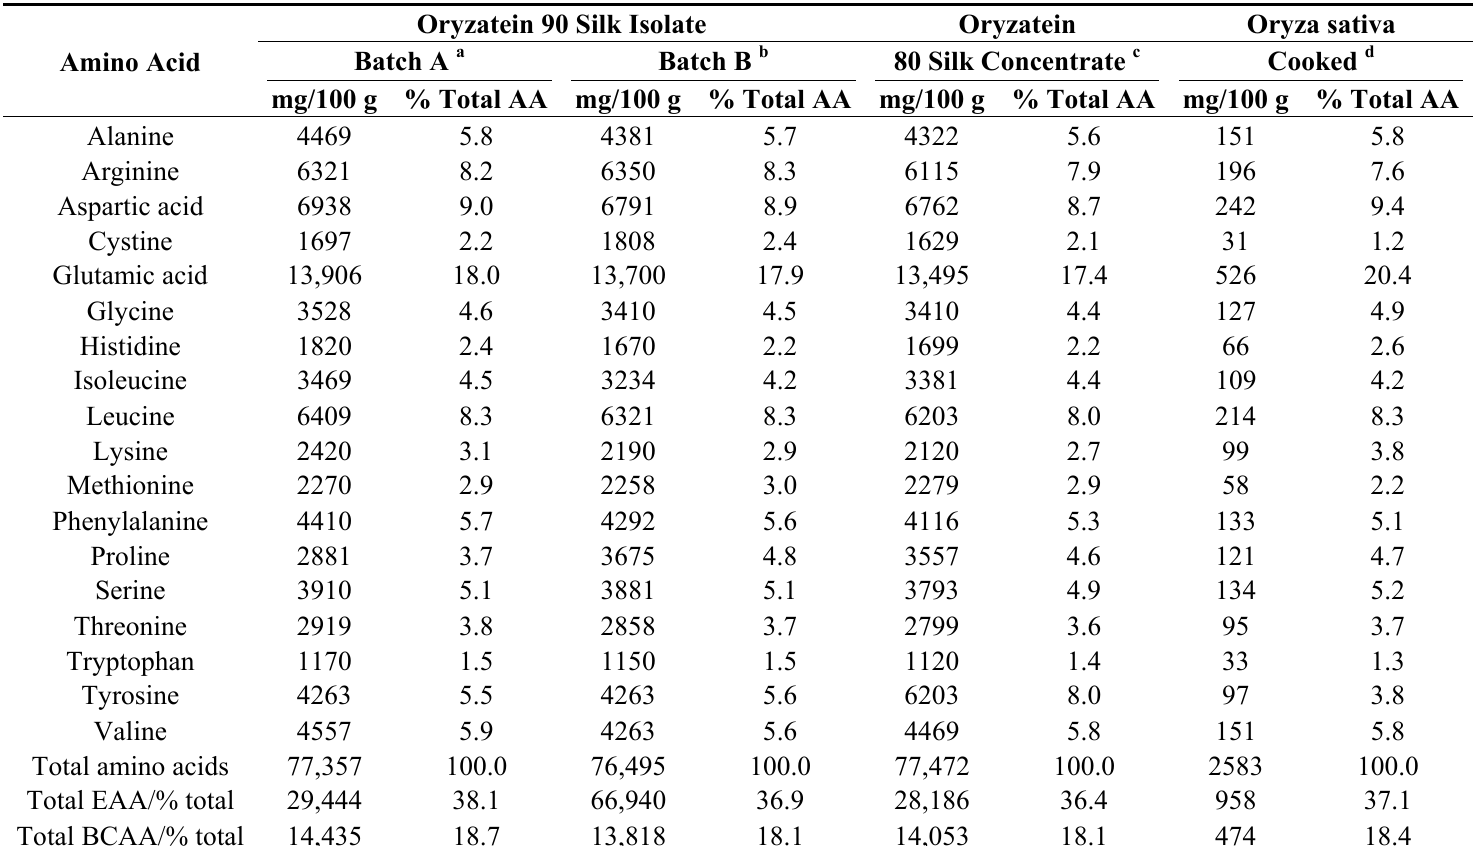
Table 1. Amino acid composition of Oryzatein Silk 90 brown rice protein isolate, Oryzatein Silk 80 brown rice protein concentrate and cooked Oryza sativa L. (brown